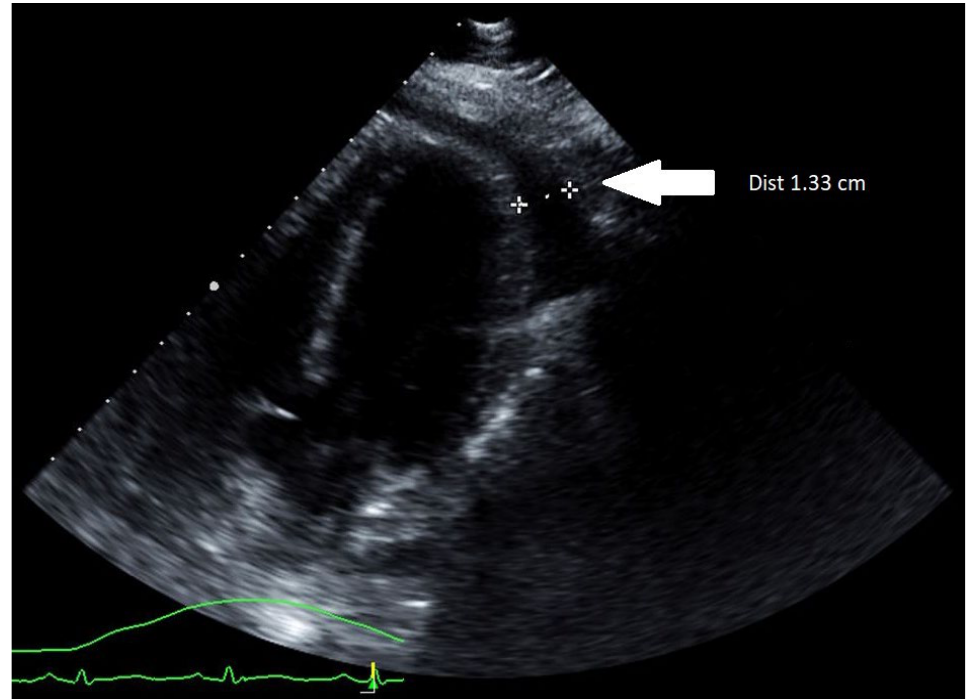
Figure 1. TTE (parasternal long-axis view) showing an increasing pericardial effusion measuring 1.33 cm (marked by two white stars).